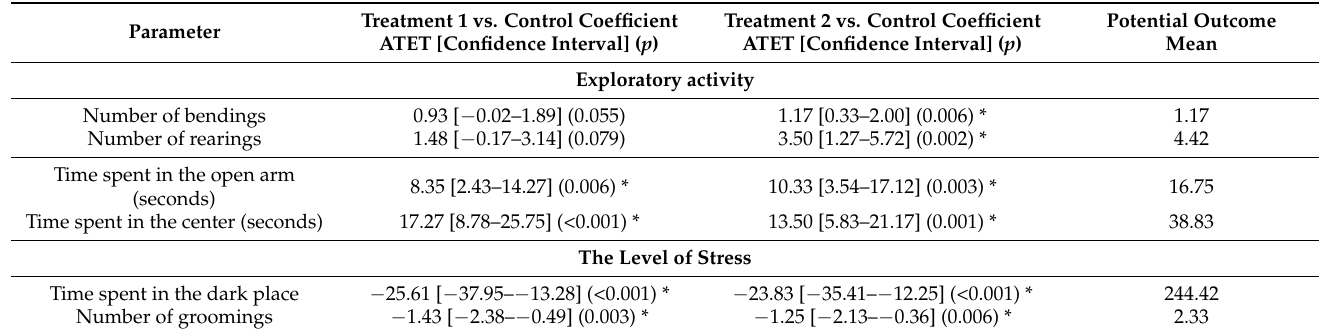
Table 6. Averaged treatment effects for the elevated plus-maze test.